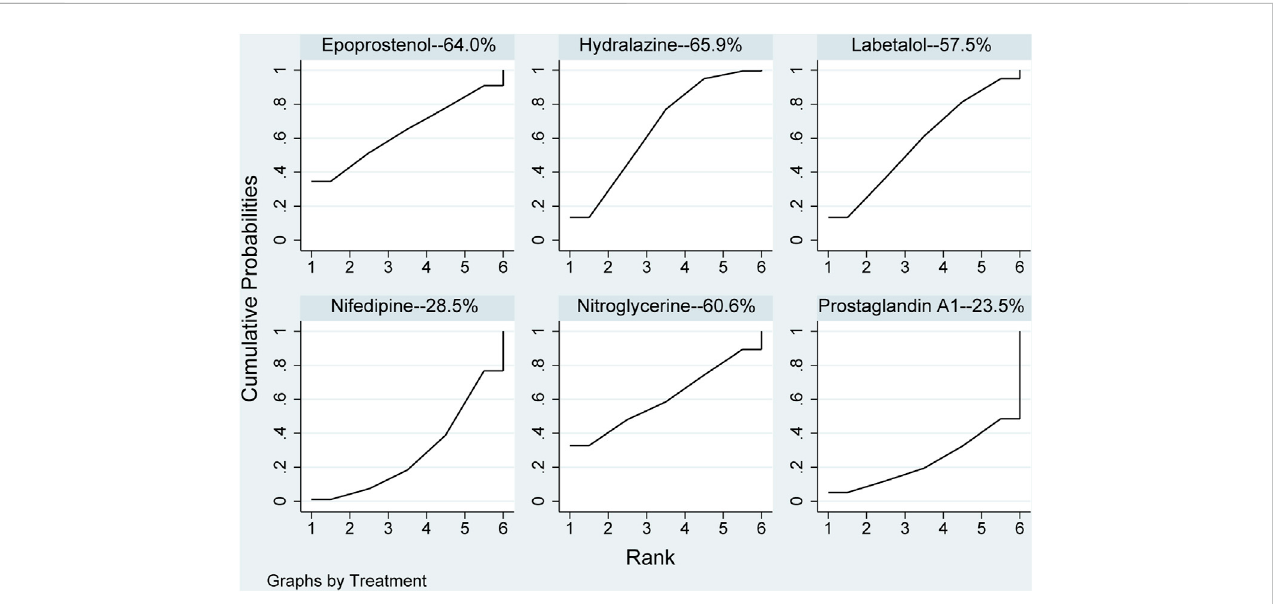
FIGURE 7 Ranking of all pharmaceuticals for diastolic blood pressure. Note: The larger the area under the curve, the more likely it is to be the best intervention. SUCRA, Surface under the cumulative ranking.